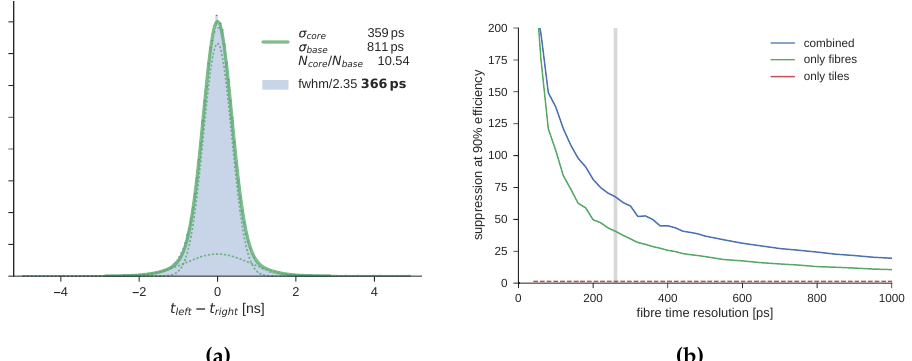
Figure 10.15: Time resolution of a 4 layer SCSF-78MJ SciFi ribbon extracted from clusters with at least 2 act- Figure 11. ( a ) Time resolution of a SciFi ribbon defined as the difference between the time measured on both sides. The global time resolution is defined as ( t left − t right ) / of accidental background as a function of the fiber detector time resolution if only the fiber detector (green) is used or both timing detectors (blue) are used. The tile detector alone has no suppression power [1].